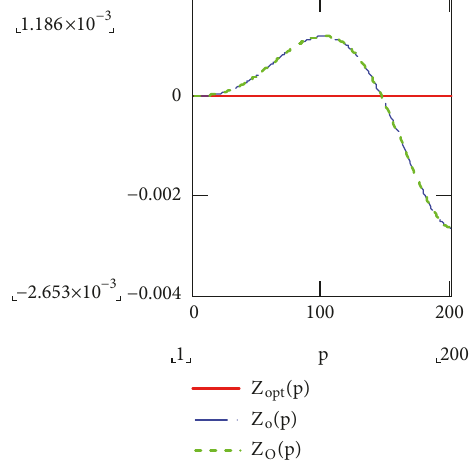
Figure 5: Objective functional value.